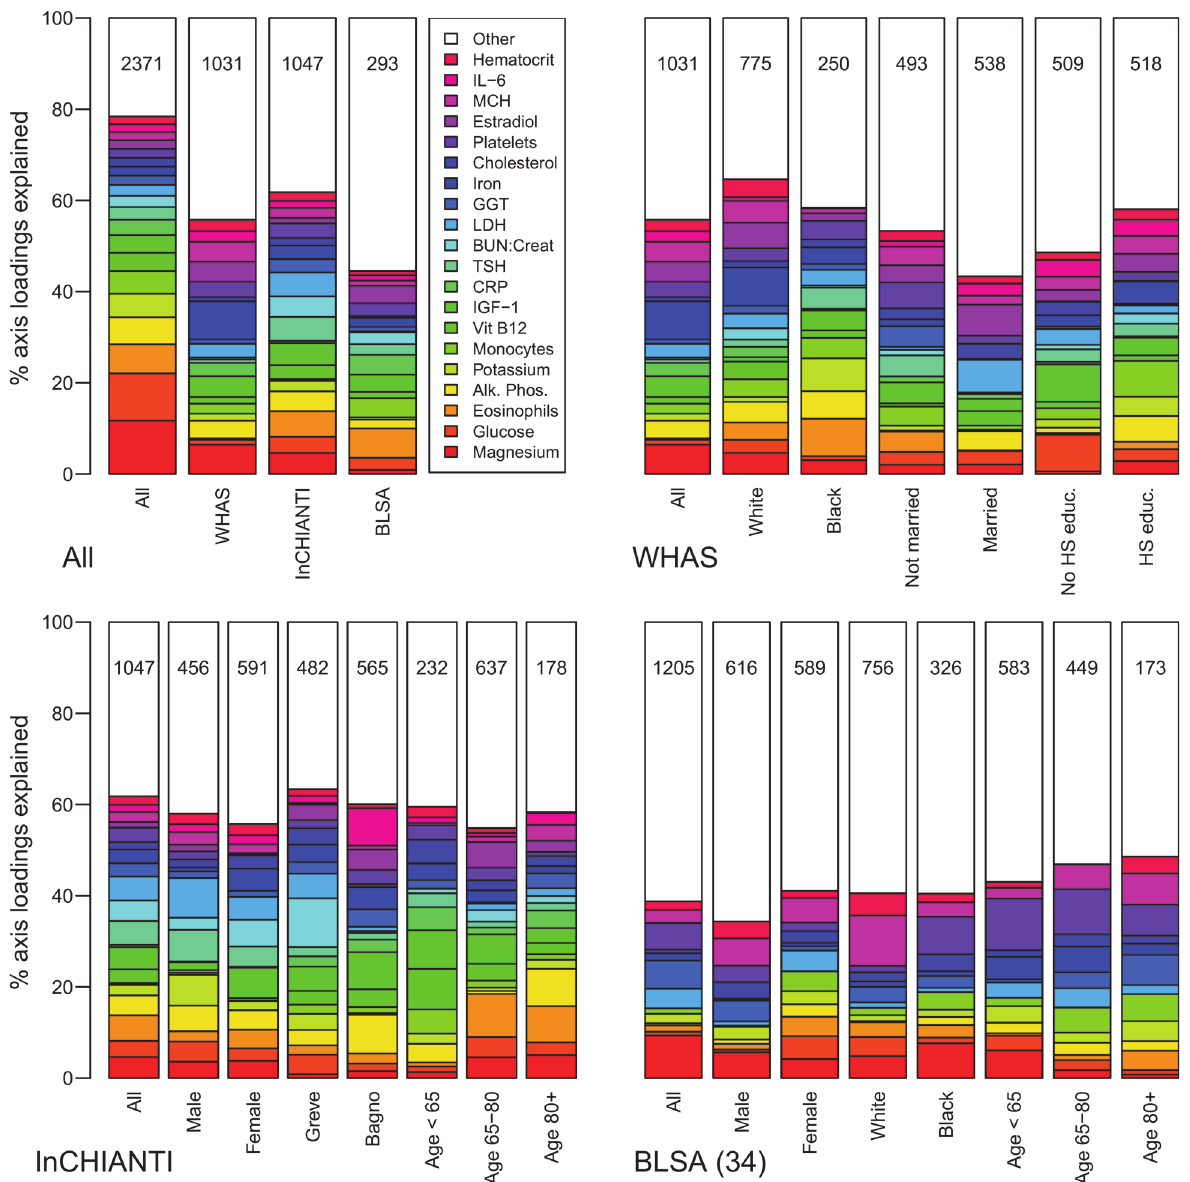
Fig 5. Biomarker loading order and stability for PCA25 (the 25 th axis, chosen randomly as an example of an unstable axis) across data sets and subsets. Loading importance is calculated as the loading divided by the sum of the absolute values of all loadings. These values are ordered from high (red, on bottom) to low (magenta, on top) for the first 20 loadings; remaining loadings are grouped together as “ Other ” in white. Accordingly, magnesium has the strongest loading, then glucose, then eosinophils, etc. The order and colors are derived from the full analysis combining the three data sets (left column, top- left panel “ All ” ) and applied to all other columns in the figure. Stability of loadings is indicated by conservation of loading heights across bars. For each panel, the loadings for the full data set are at left. Numbers indicate subset sample sizes. For all panels except BLSA, the 43-variable set is used; for BLSA there was insufficient sample size to perform PCA on subsets with 43 variables, so the 34-variable analysis is